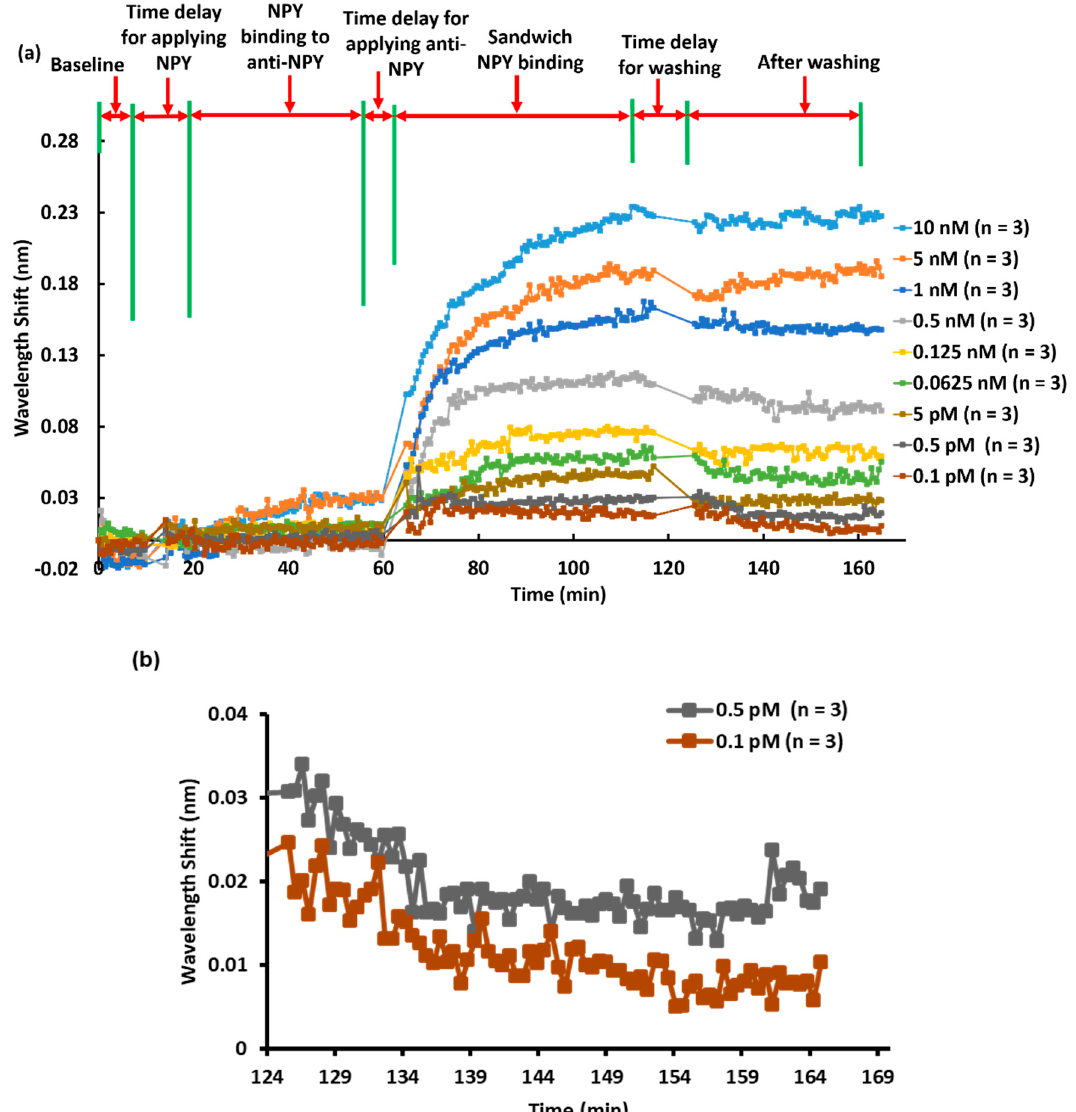
Figure 5. ( a ) Process steps and averaged (in triplicates) wavelength shift response for the NPY sandwich assay as a function of NPY concentration. ( b ) Zoomed-in results for 0.1 and 0.5 pM NPY after the washing step, demonstrating the limit of detection (LOD) pertinent to these experiments.